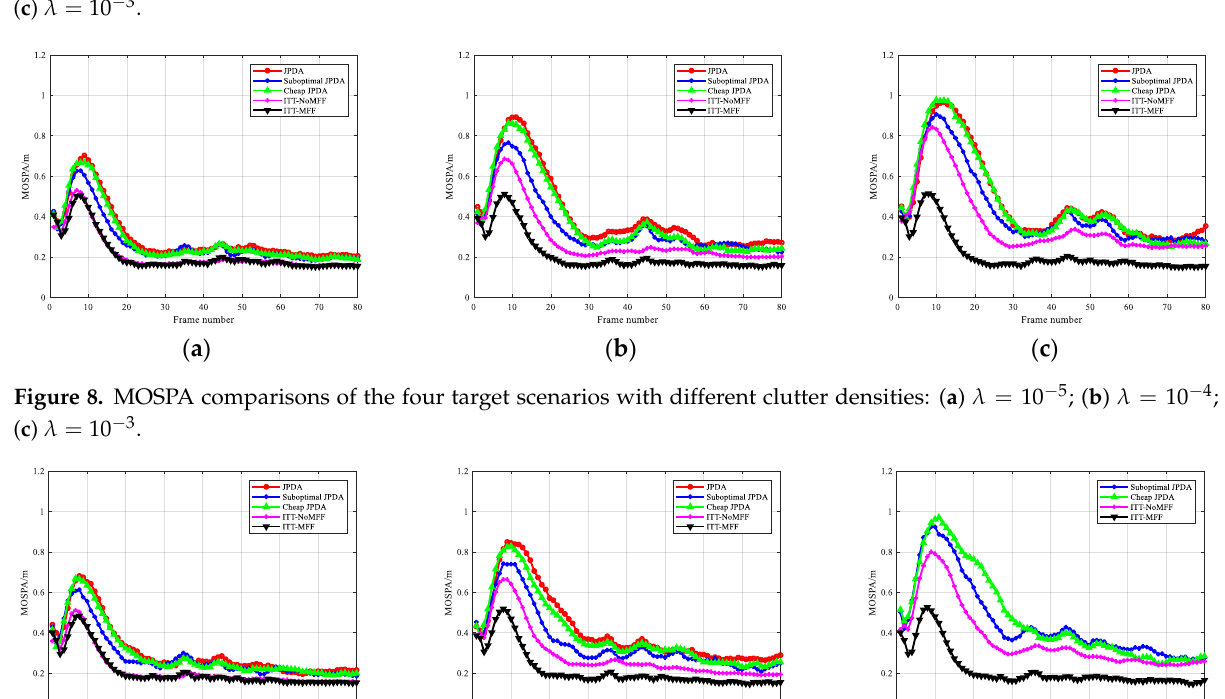
Figure 9. MOSPA comparisons of the six target scenarios with different clutter densities. ( a ) λ = 10 ( c ) λ = 10 − 3